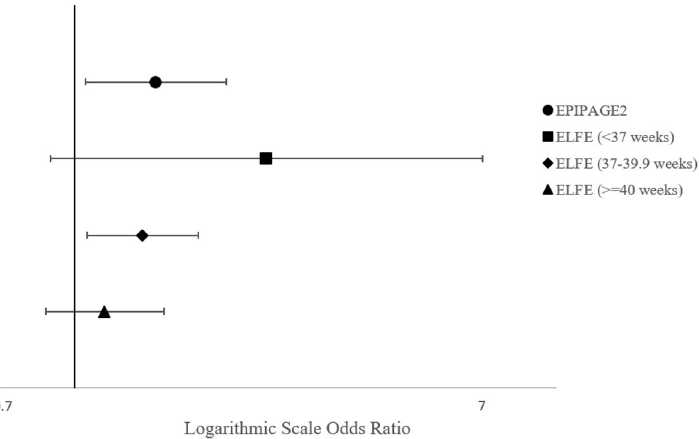
Figure 3. Adjusted Odds ratios for maternal pre-pregnancy obesity and high hyperactivity-inattention symptom scores (≥ 7) by gestational age group in children 5 years old from the ELFE (n = 10,898) and EPIPAGE 2 (n = 2646) cohort studies . a Adjusted for maternal age at birth, maternal education, household income (ELFE), household socioeconomic category (EPIPAGE 2), parity, sex, psychological problems during pregnancy (ELFE), anxiety symptoms (EPIPAGE 2), singleton pregnancy (EPIPAGE 2), maternal physical activity during pregnancy (ELFE), maternal healthy diet score during pregnancy (ELFE), maternal alcohol intake during pregnancy (ELFE), maternal smoking during pregnancy, child age at evaluation, gestational age, breastfeeding, cause of prematurity (EPIPAGE 2) childcare at 2 years, screentime at 2 years (ELFE), HOME score (EPIPAGE 2), difficulties falling asleep at 2 years (ELFE) and frequent night waking at 2 years (EPIPAGE 2). b Missing covariates are imputed and weighted using